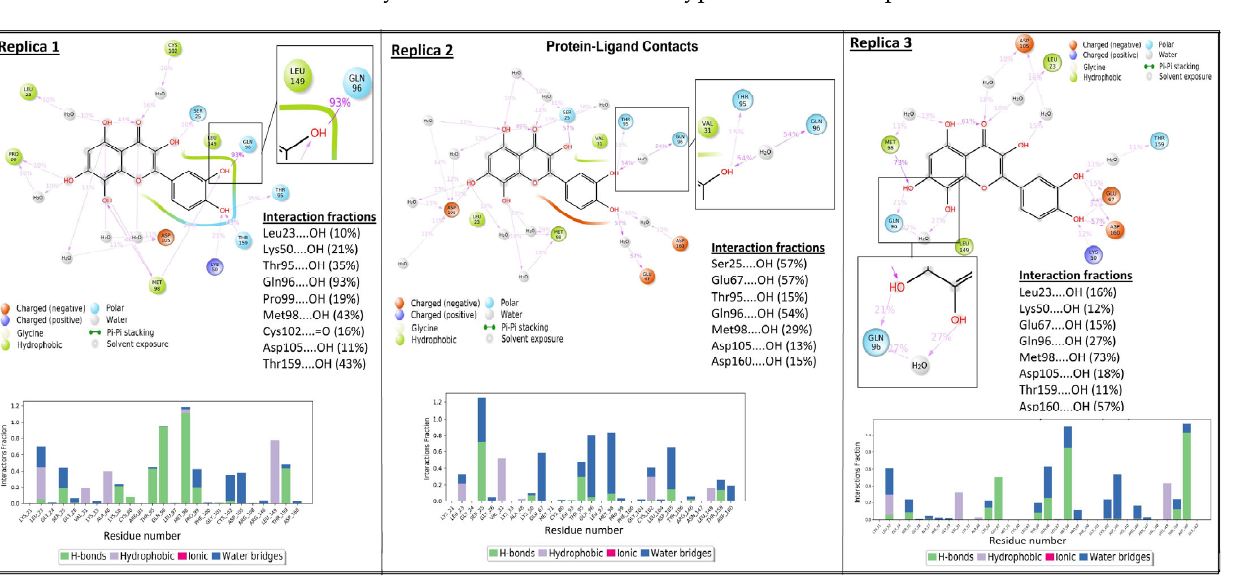
Figure 10. EGFR–Gossypetin complex 100 ns MD production run. ( A ) Protein RMSF plot. ( B ) Gyra ‐ tion plot depicting the extendedness of a ligand. ( C ) Gyration plot of protein during a 100 ns pro ‐ duction run.